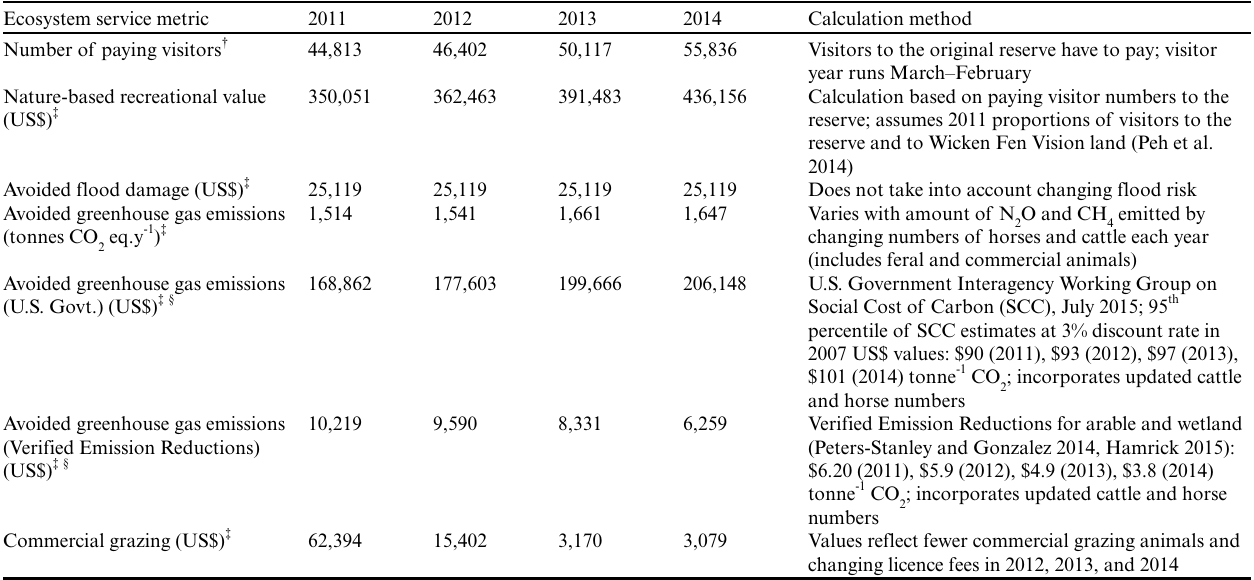
Table 2 . Ecosystem service values of the Wicken Fen Vision project for